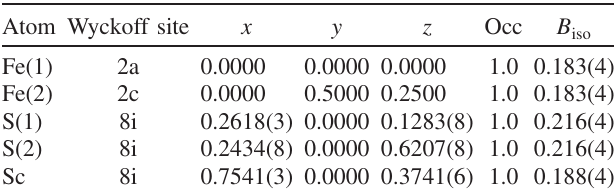
TABLE I. Atomic parameters for the proposed low- temperature tetragonal structure of FeSc 2 S 4 at 20 K. The space ¯4 m 2 (119) with lattice parameters a ¼ 7 . 434 ð 1 Þ Å and group is I c ¼ 10 . 493 ð 1 Þ Å. Reitveld refinements result in a χ 2 of 1.33 and ¼ 5 . 25% . All site occupancies (Occ) refined to 1. Includ- R Bragg ing Fe-Sc antisite inversion of 3% reduces χ 2 to